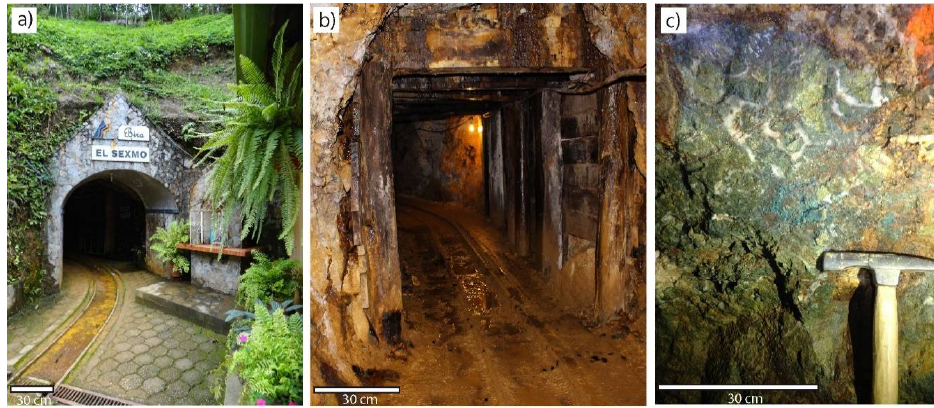
Figure 6. Example of mining site (e.g., Mina el Sexmo) inventoried in the study area. ( a ) Mine entrance, ( b ) underground passage [38], ( c ) mineralization inside the mine. Table 4. Assessment of the degree of interest of the geosites and mining sites (*). Scientific (Sc), Academic (Ac), Tourism (To) and Average.